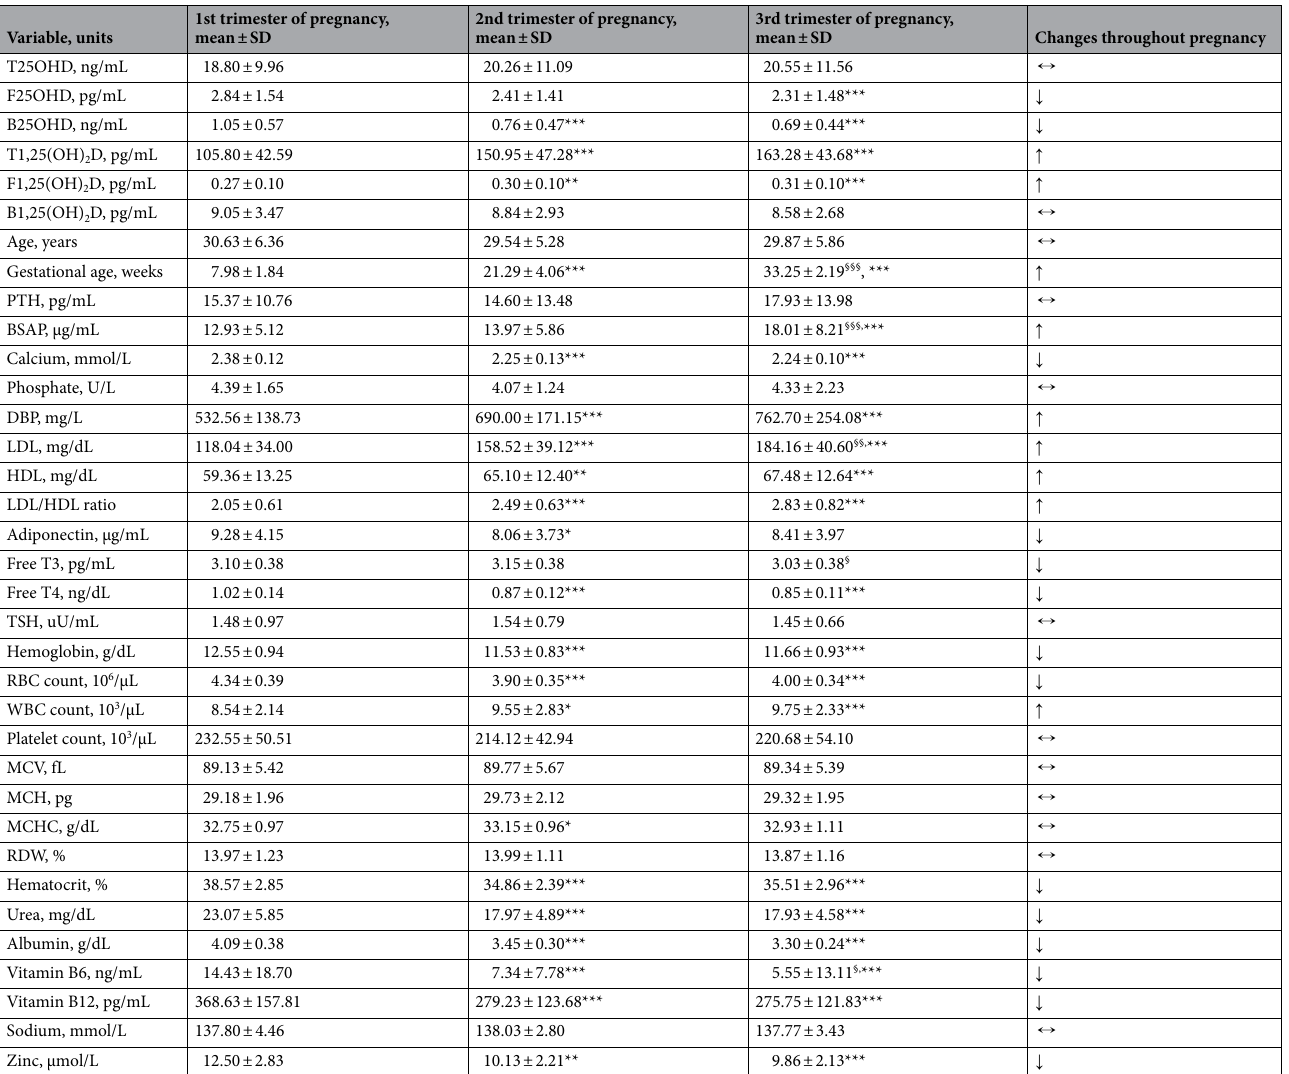
Table 1. Biochemical characteristics of the study population. Mean values ± standard deviation of age and gestational age, vitamin D metabolites and biochemical, hematological, and endocrinological serum parameters in 1st, 2nd, and 3rd pregnancy trimesters. B25OHD, bioavailable 25OHD; B1,25(OH) 2 D, bioavaialble